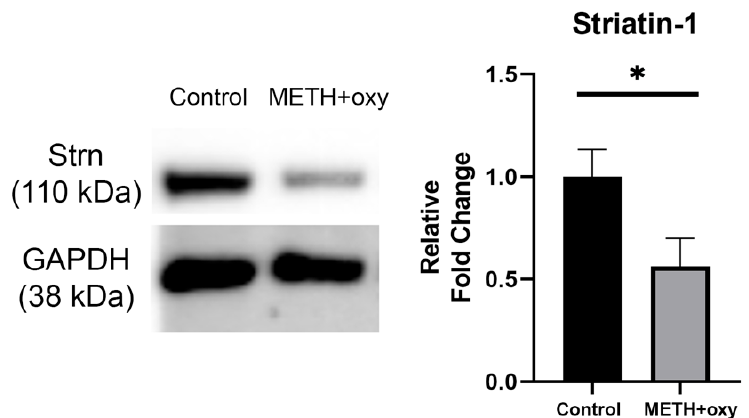
Figure 4. Validation of Striatin-1 downregulation. The downregulation of Striatin-1 was found to be statistically significant utilizing an unpaired t -test following Welch’s correction (* p < 0.05). Representative Western blots are displayed here. Relative fold-change data are depicted as mean ± SEM (n = 10).